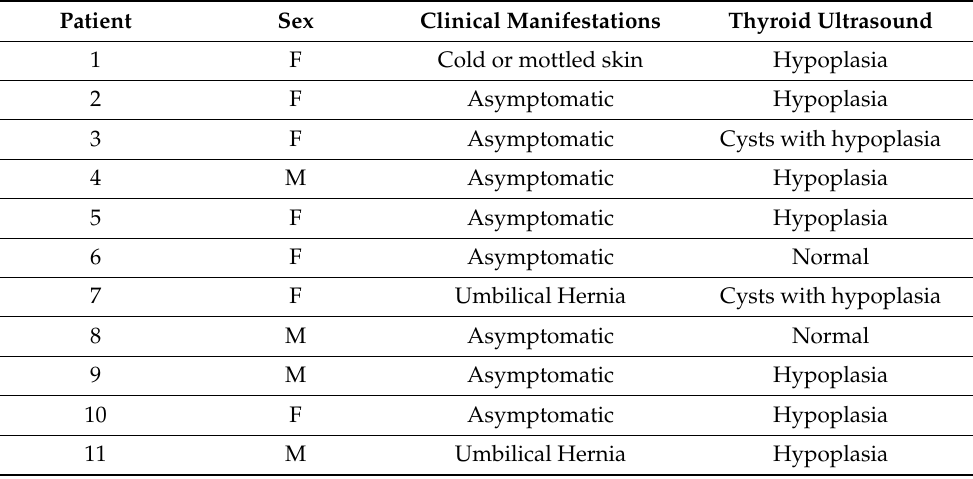
Table 2. Clinical manifestations of congenital hypothyroidism at the recall